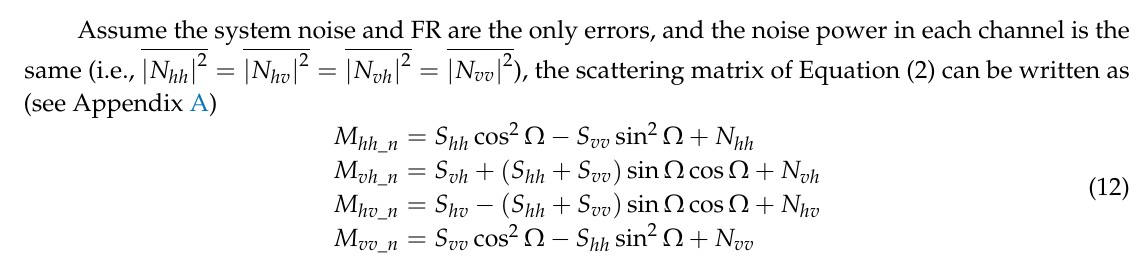
Figure 6. Two-dimensional CIT reconstructions without system errors in Qingdao. ( a , c ) are the reconstructed results based on proposed and traditional CIT methods, respectively. ( b , d ) are the corresponding absolute deviations between the true and reconstructed results. The unit of the electron density is electrons · m − 3